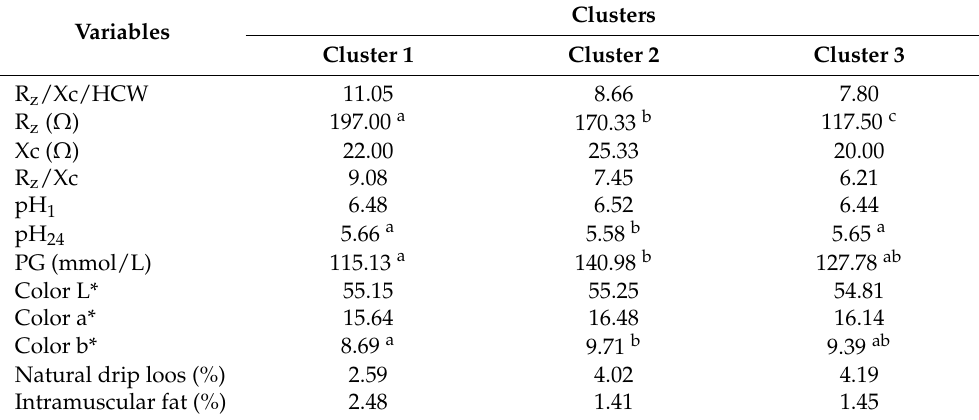
Table 4. Mean values for clusters obtained from the cluster analysis using the K-means